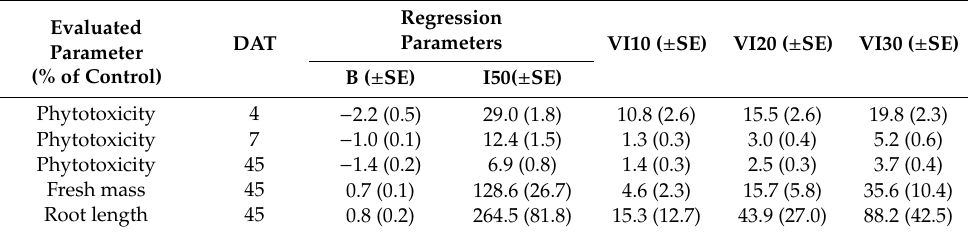
Table 2. Glyphosate doses g ha − 1 that resulted in 10%, 20% and 30% [VI10, VI20 and VI30 ( ± SE)] for the response of A. retroflexus on measured parameters (% of